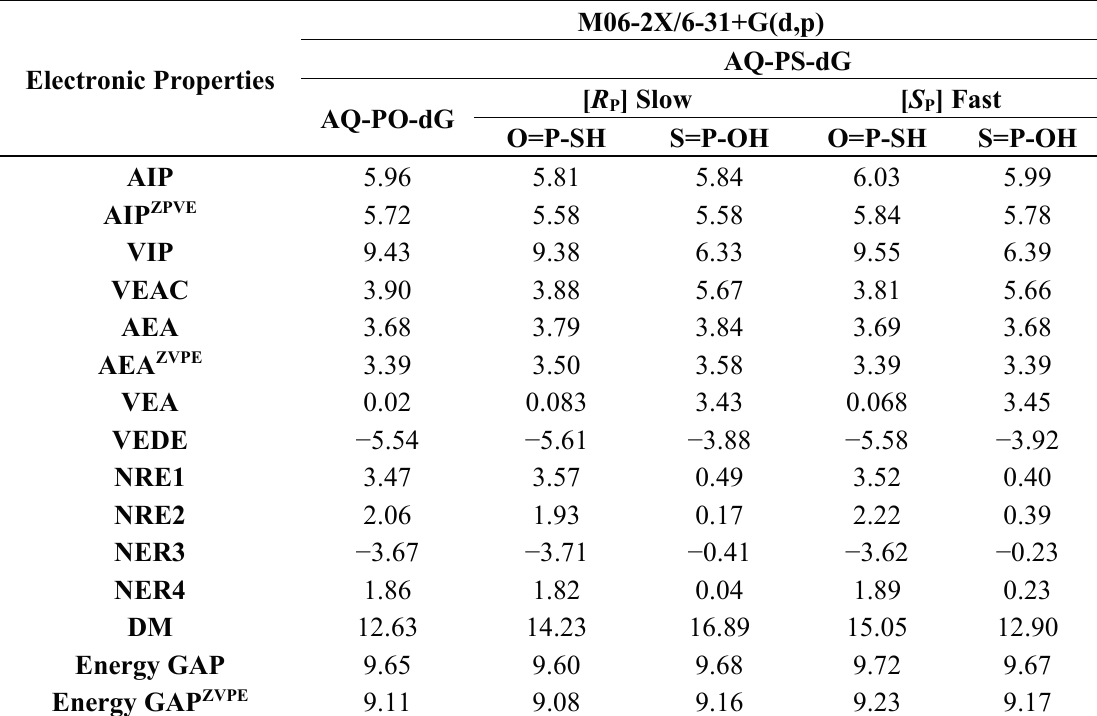
Figure 4. A spatial geometry comparison between AQ-PO-dG colored by elements, [ R P ] AQ-PS-dG—yellow and [ S P ] AQ-PS-dG—green after pentose ring overlap. The structures have been optimized at the M06-2X/6-31+G(d,p) level of theory in the aqueous phase in different protonated forms: ( A ) O=P-SH and ( B ) S=P-OH. Table 2. The electronic properties of [ R P ] AQ-PS-dG, [ S P ] AQ-PS-dG, AQ-PO-dG obtained by calculation at M06-2X/6-31+G(d,p) and TD M06-2X/6-31++G(d,p) levels of theory in the aqueous phase, see Figure S13 (S—Supplementary Materials). Energy values given in eV and dipole moment (DM) in